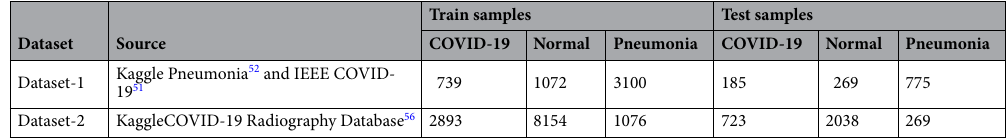
Table 1. Distribution of datasets for training and evaluating the present TOPCONet model.